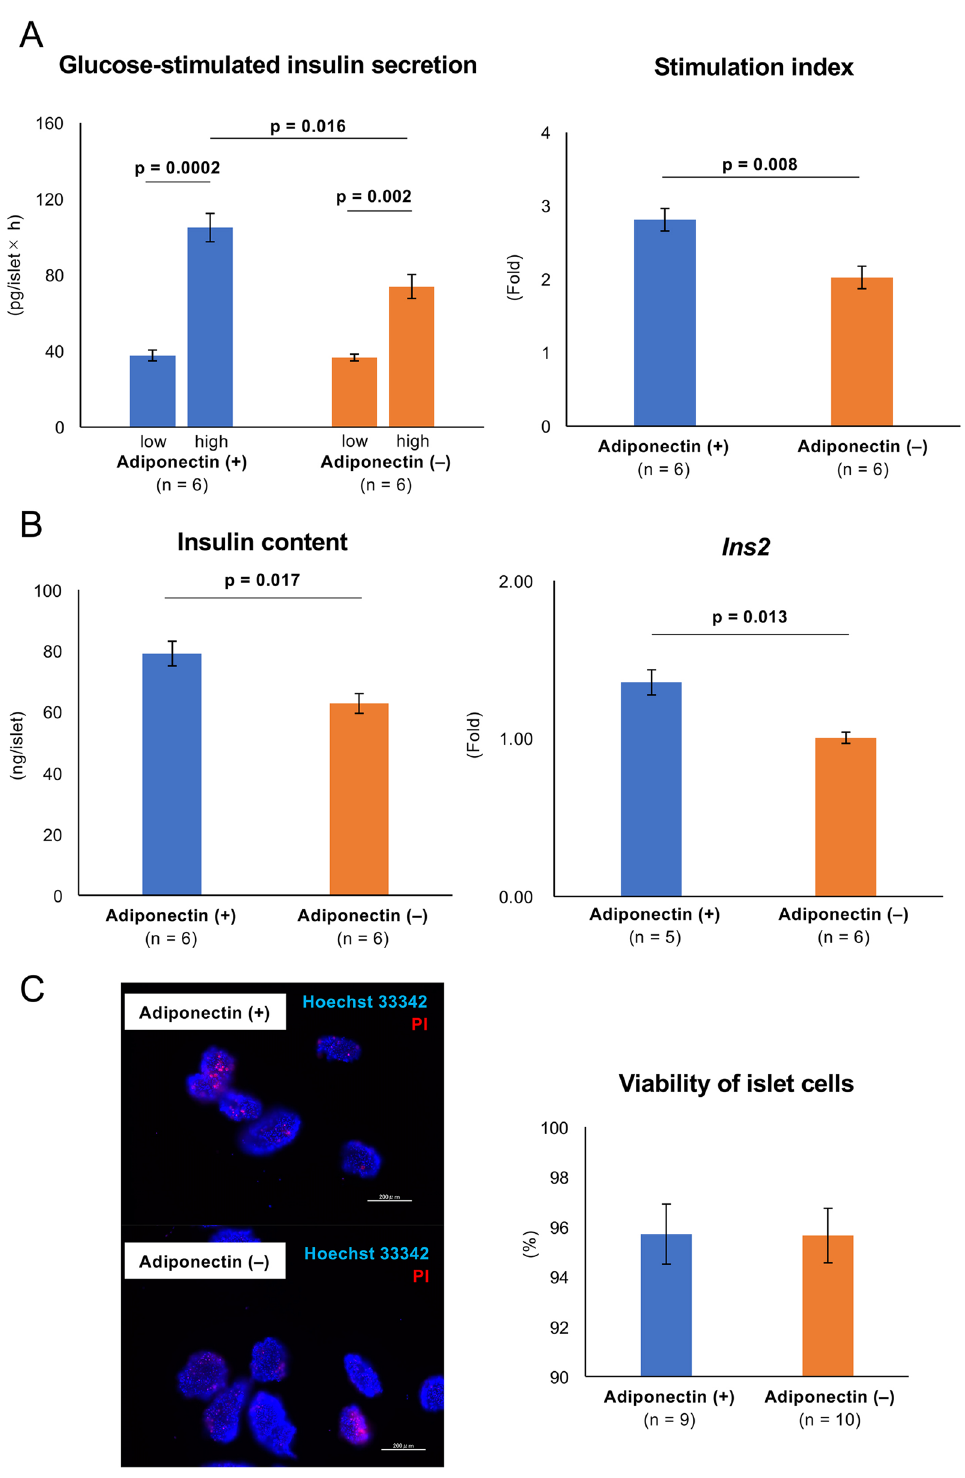
Figure 2. GSIS, volume of insulin in islets, and viability of islets. GSIS ( A ), volume of insulin ( B ), and viability ( C ) of islets treated with adiponectin (adiponectin (+), blue) and without adiponectin (adiponectin (−), orange). ( A ) Amount of insulin released from islets under conditions of low and high glucose stimulation (left) and the stimulation index (right). ( B ) Insulin content in islets (left) and Ins2 expression in islets quantified by qRT- PCR (right). The results were normalized to the β-actin gene and are presented as the fold difference over the detectable Ct value, which was calculated using the ΔΔCt method. ( C ) Staining to evaluate the viability of islet cells (left). Hoechst 33342 (blue) was used to stain all islet cells, and propidium iodide (PI; red) stained all dead islet cells. Cellular viability of islets (right). Data are presented as means ± standard error of the mean. A p -value < 0.05 was considered statistically